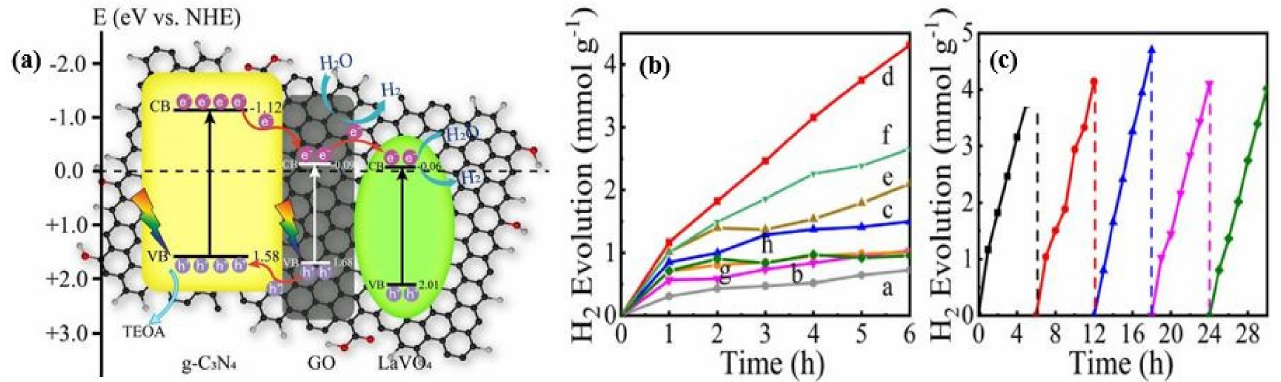
Figure 9. ( a ) Photo-produced electron transfer scheme over the GO-C 3 N 4 -LaVO 4 composite. ( b ) Dynamic curves of H 2 produced over the as-prepared GO-C 3 N 4 -a, the physical mixture of GO-C 3 N 4 and LaVO 4 -b, the physical mixture of GO, C 3 N 4 and LaVO 4 -c, GO-C 3 N 4 (1:1)-LaVO 4 nanocomposite-d, g-C 3 N 4 -LaVO 4 -e, GO-LaVO 4 -f, pure g-C 3 N 4 , g- and LaVO 4 -h, respectively. ( c ) Cyclings of H 2 production over the GO-C 3 N 4 -LaVO 4 composite. (Reprinted with permission from reference [129]. Copyright 2021,